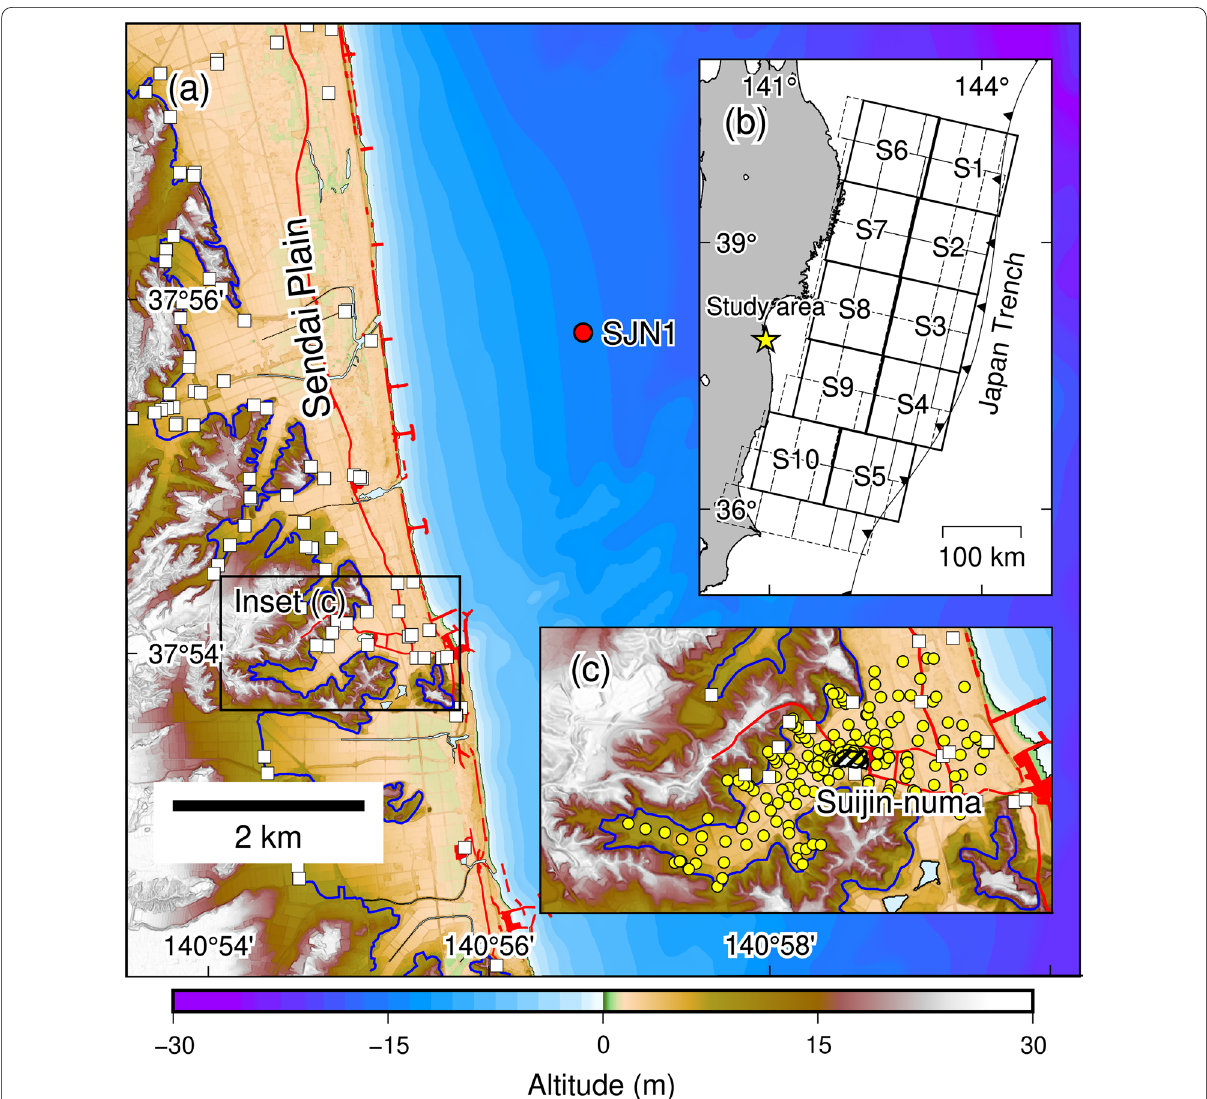
Fig. 1 Study area and fault models. a Topography and bathymetry map of the calculated Domain R6. White rectangles and red polygons indicate the survey point of tsunami trace height (Mori et al. 2012) and fixed bed, respectively. The blue line represents the inundation limit (Haraguchi and Iwamatsu 2013). b Fault models. Bold solid and thin dashed rectangles indicate the geometry of the fault model proposed by Hayashi and Koshimura (2012) and Satake et al. (2013), respectively. c Enlarged view around the Suijin-numa pond. Yellow circles represent the survey points of tsunami deposits (Abe et al.